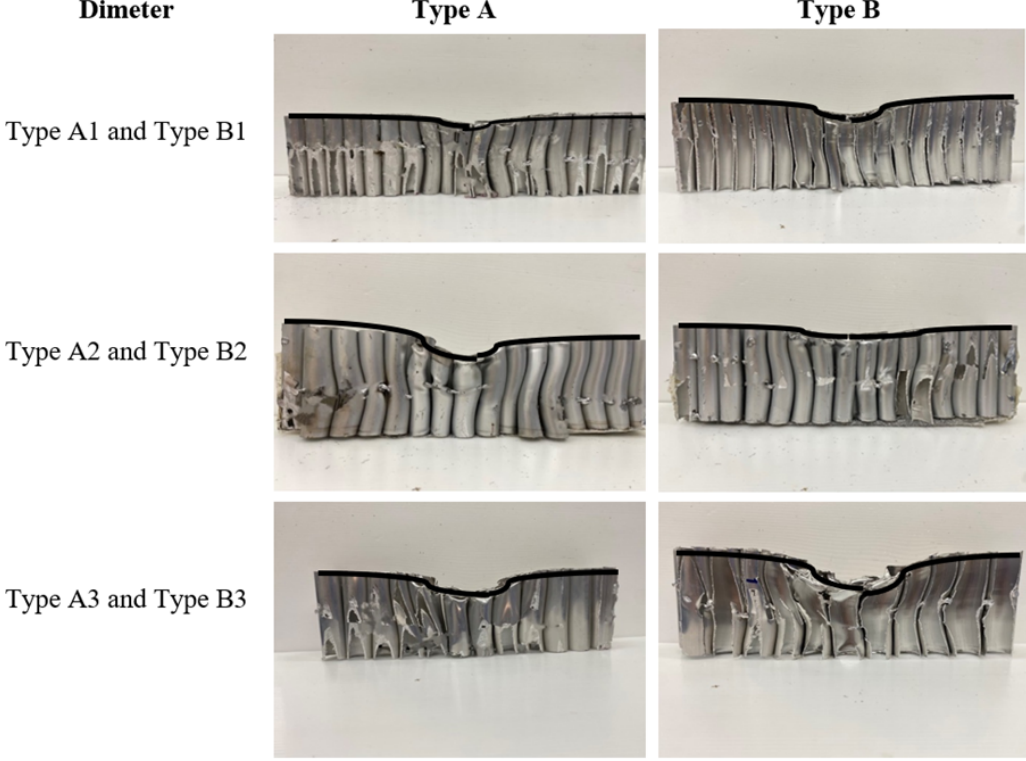
Figure 6: Collapse patterns of Type A and Type B at a height of 4 m Table 3: Results of P max , P mean , and displacement ( S ) of experimental and FEA